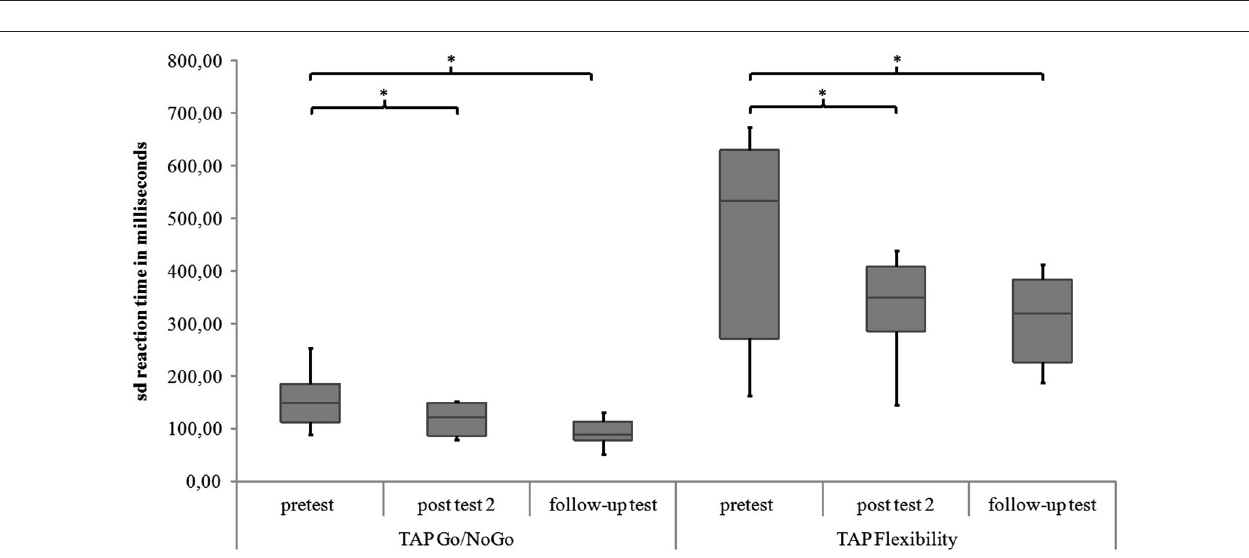
FIGURE 6 | Standard deviations of reaction times for the TAP subtests Go/NoGo and Flexibility for all measurement points . Middle line of boxes = median, box = interquartile range, error bars = minimum respectively maximum, * = significant.